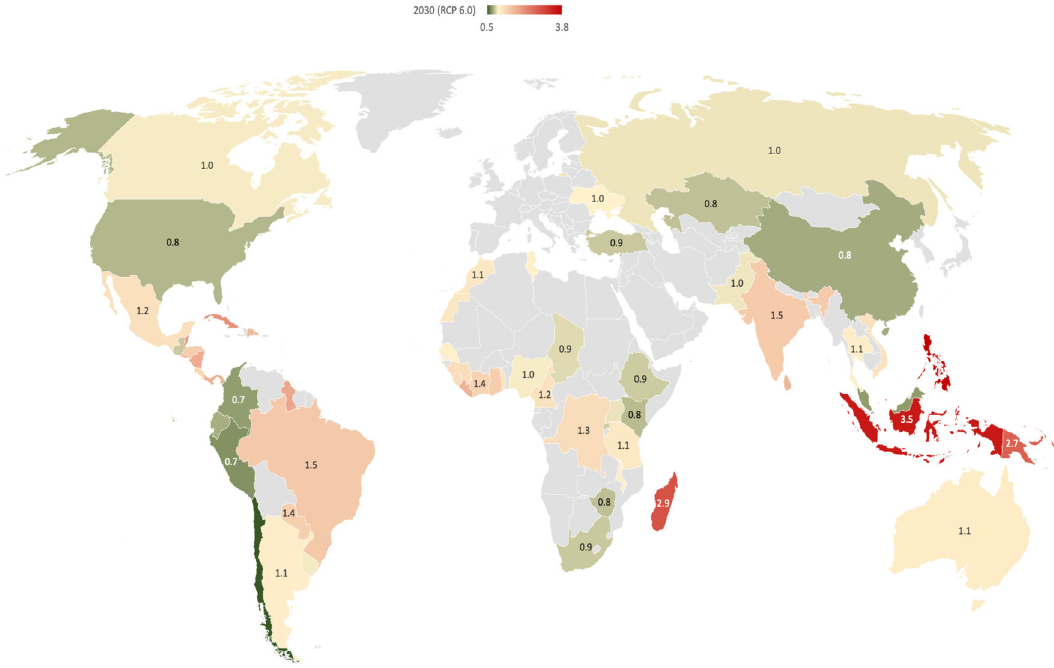
Fig. 2 Cross-border climate vulnerability score (CCVS) of the EU ’ s agri-food economy to drought per exporting country in 2050 under the RCP 6.0 concentration pathway. The fi gure only represents countries that account for more than 0.1% of the total green virtual water import by the EU. Together, these countries represent more than 99% of the total external rainfall dependency of the EU. Green to red colors indicate CCVSs in ascending order.